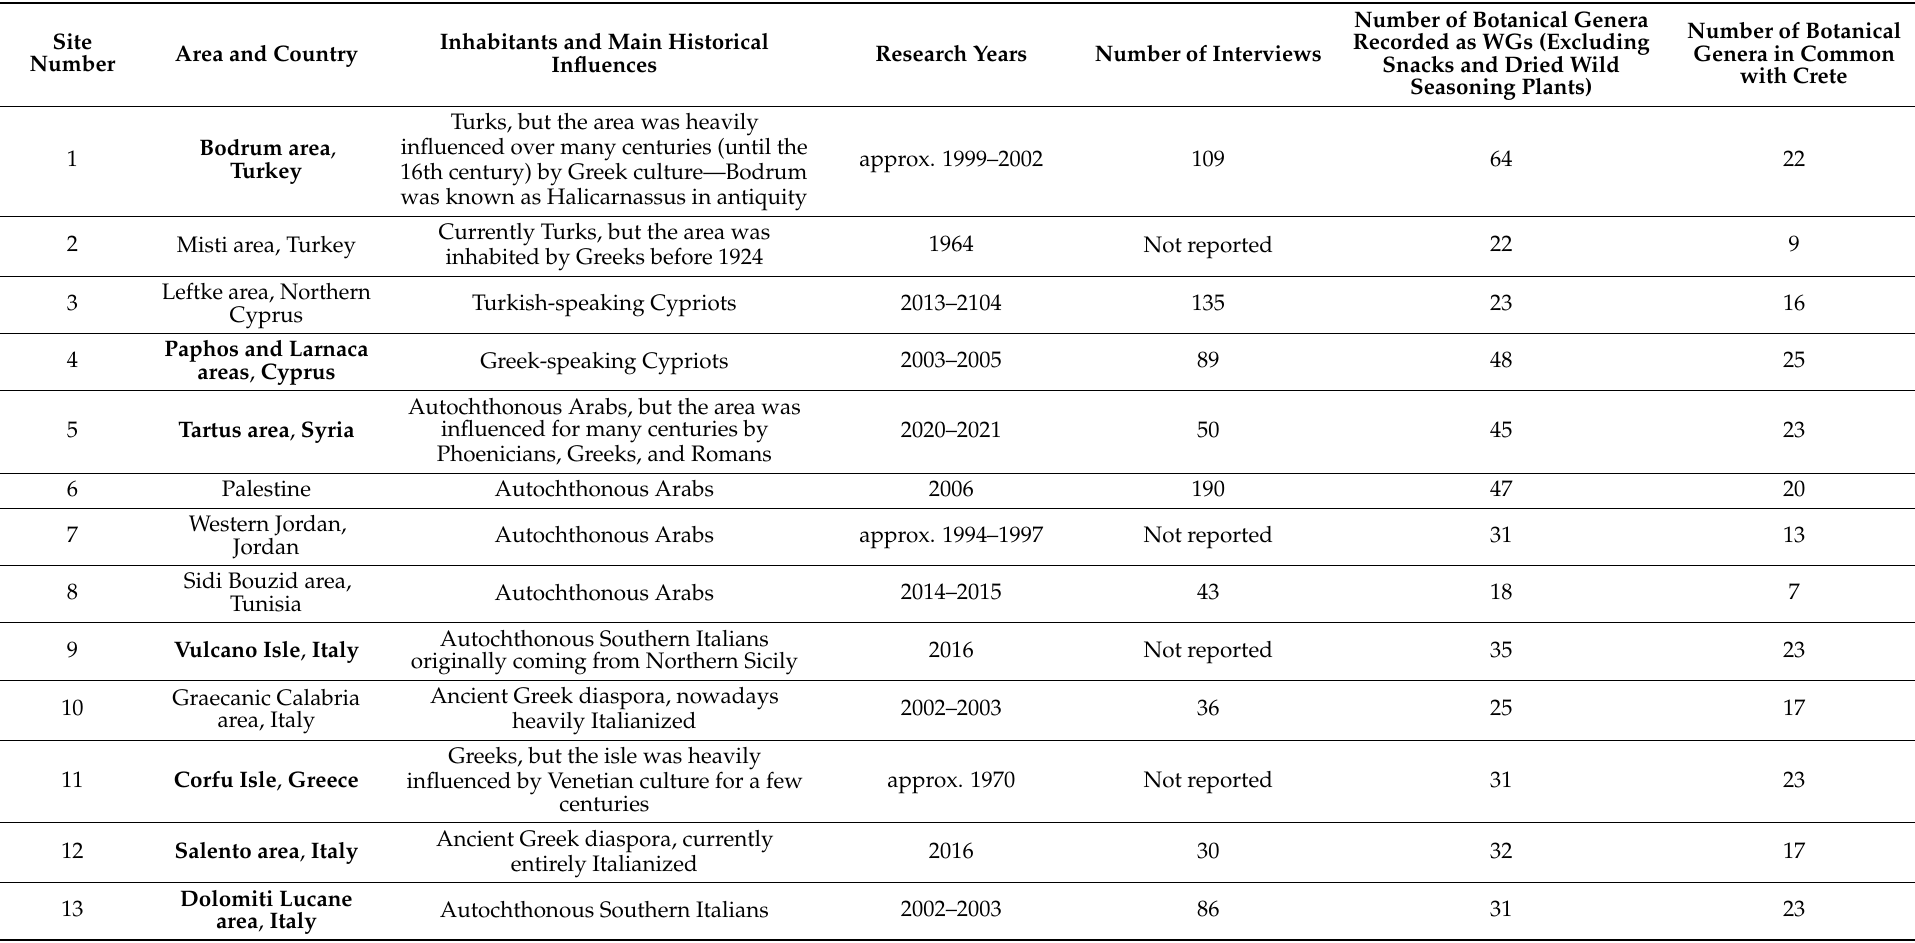
Table 4. Comparison between Cretan wild greens (botanical genera) and those quoted in other ethnobotanical studies previously conducted in Eastern and Central Mediterranean and among Assyrians in Iraqi Kurdistan [51]; see Figure 3 and Table 2 for details; in bold we reported the areas where the similarities are